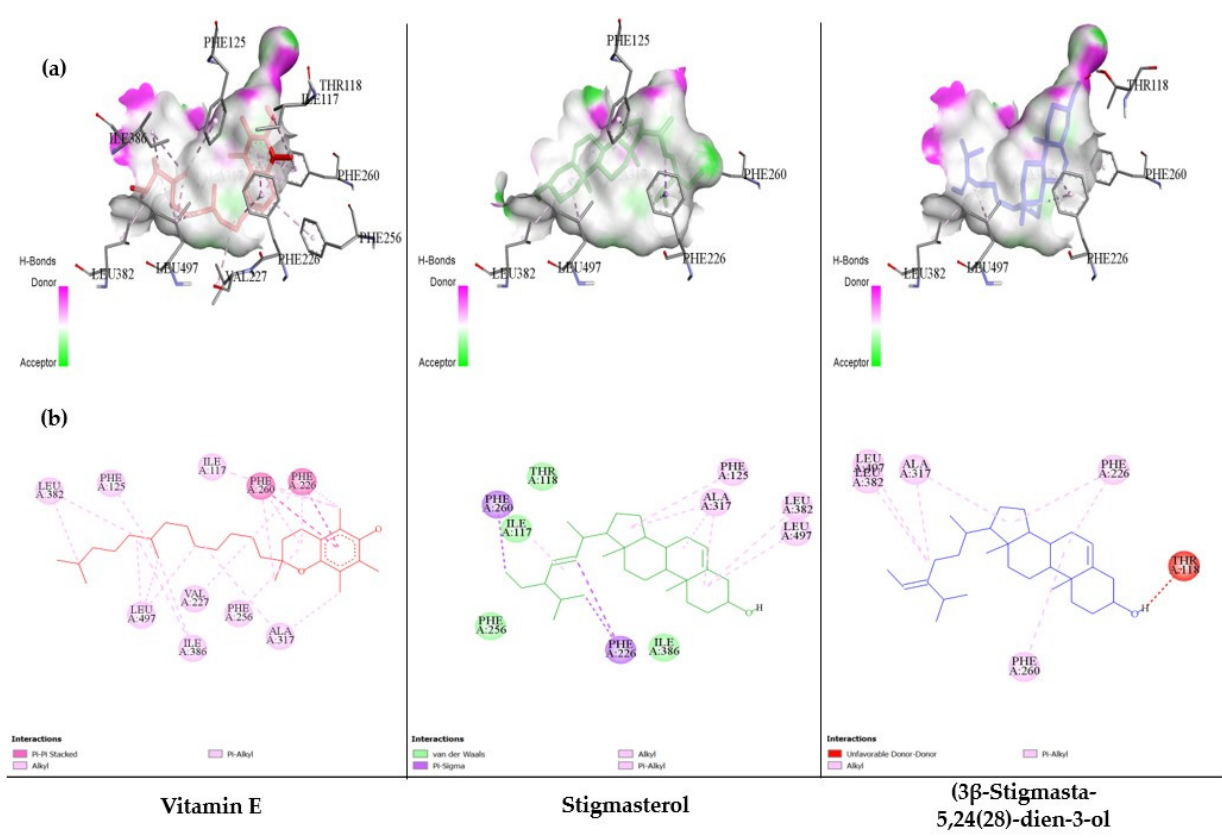
Figure 9. The results of the molecular docking study of CYP1A2 (2HI4) are represented by the 3D diagrams of interaction between each phytochemical and 2HI4 ( a ) and by the 2D diagrams of phytochemical–receptor interactions ( b ). Table 4. Docking results of the compounds with 1 CYP1B1 ( 2 PDB ID: 3PM0).